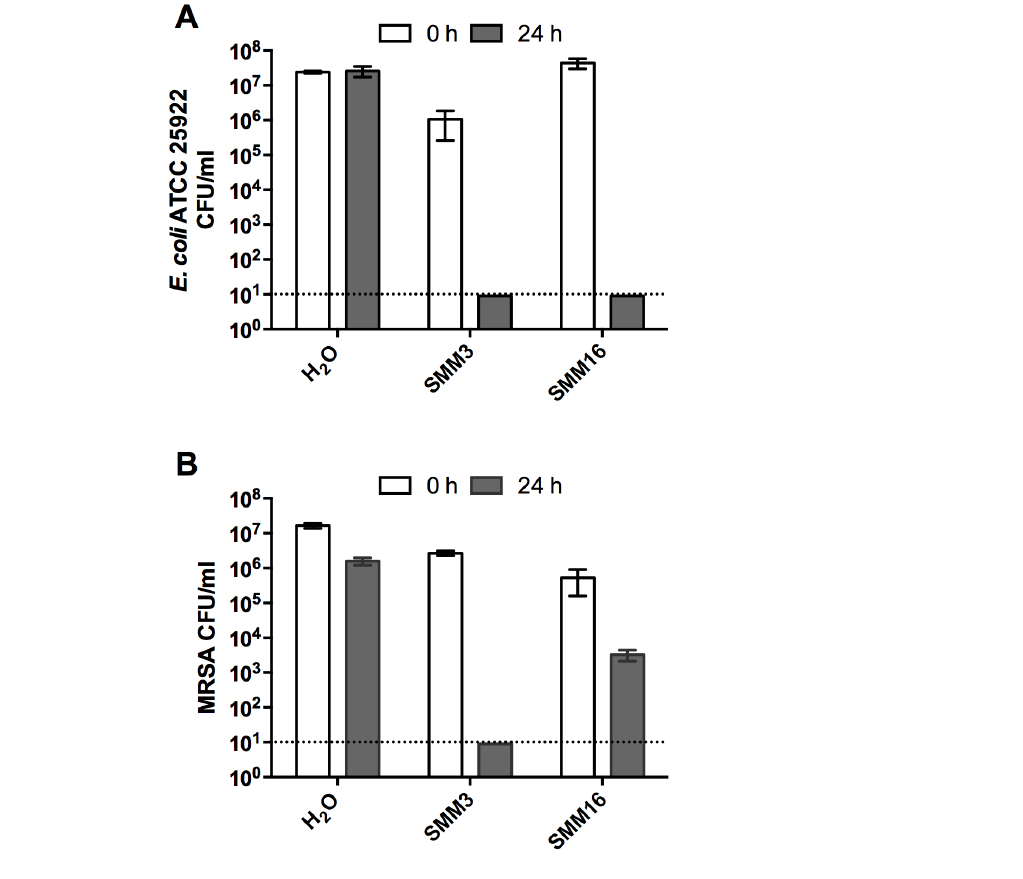
Fig. 8. Assessment of E. coli ATCC 25922 (A) and MRSA (B) viability following exposure to SMM3 and SMM16 synthetic microbicidal mixtures of metal salts. The dotted line represents the limit of detection.